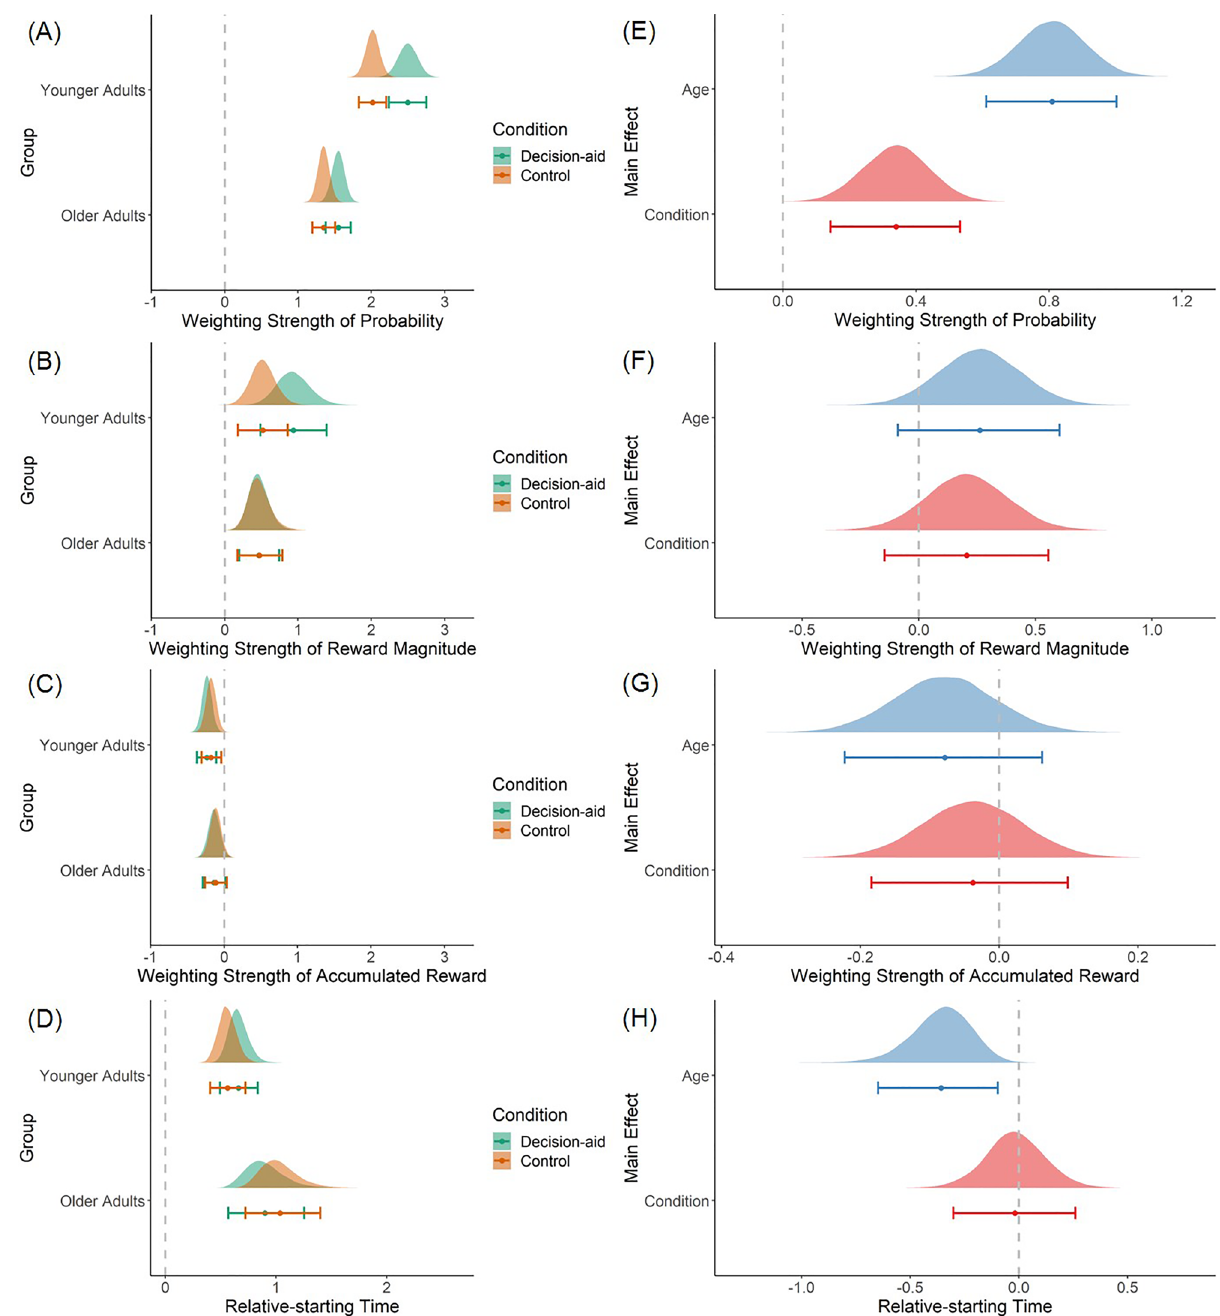
Figure 2. Effects of age group and condition on the drift weight and relative starting time parameters of stDDM (M3). ( A – D ) Posterior distributions of the group-level parameters from the best fitting model (M3) in all experimental conditions in both age groups. ( E – H ) Age and condition differences of the posterior distributions of the hyperparameters in the best fitting model (M3). Age group differences are shown as younger minus older adults. Condition differences are shown as aid minus control. Note. Dots and error bars shown below the distribution plots indicate the mean and 95% highest density interval,